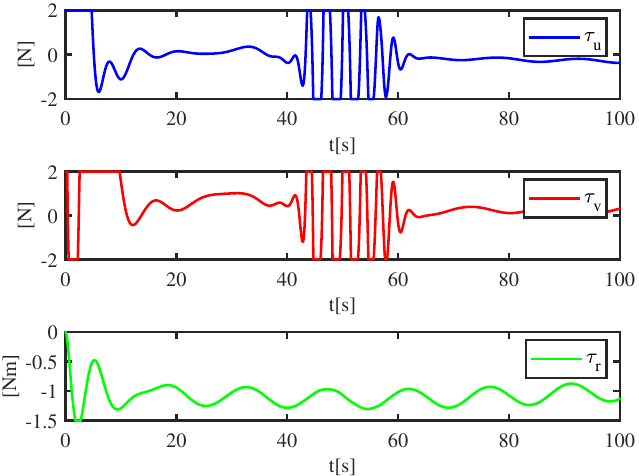
Figure 10. Control inputs under non-cooperative